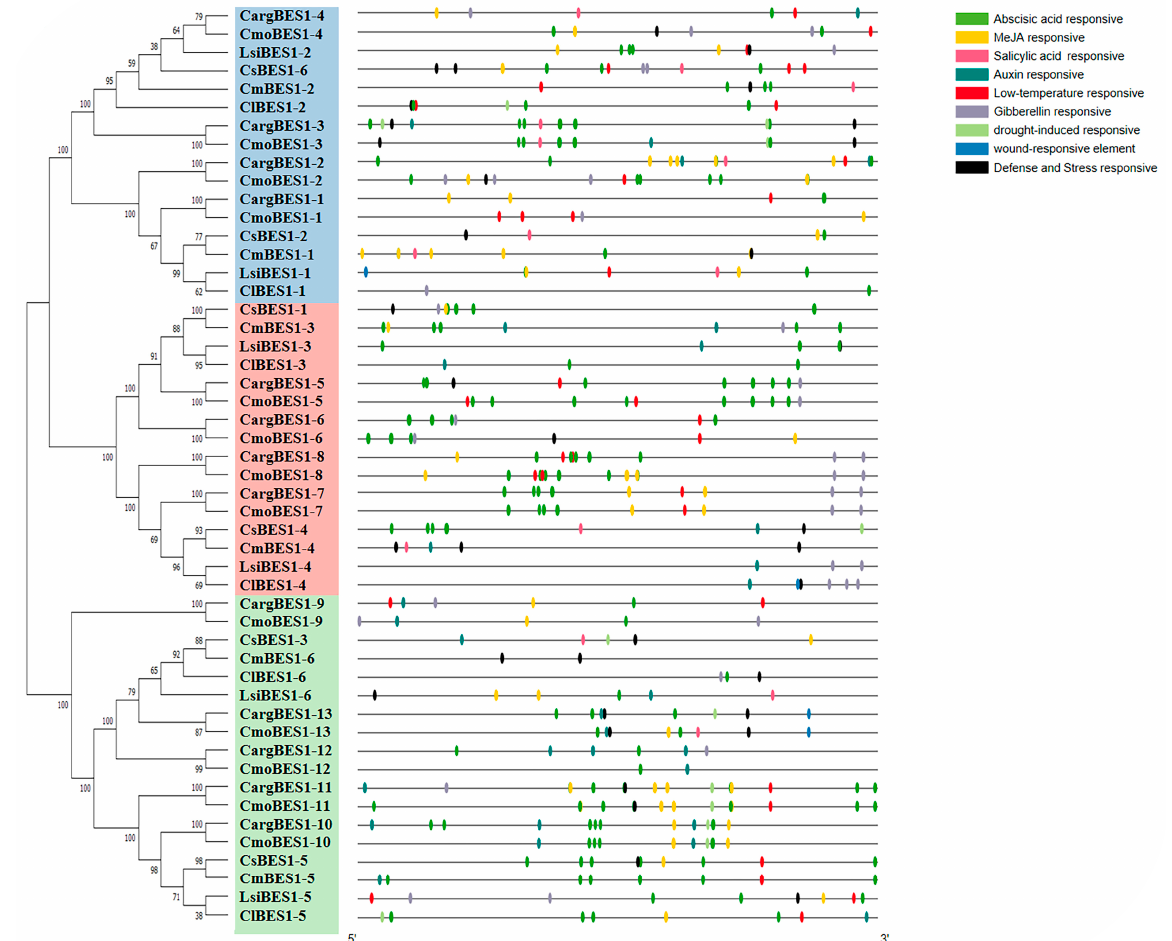
Figure 4. The distribution of stress-responsive cis -acting elements in the promoter regions of BES1 genes of silver-seed gourd, watermelon, cucumber, winter squash, bottle gourd, and melon. The cis -acting regulators of the 2 Kbp sequence upstream of BES1s were predicted through the PlantCARE database website. The green, yellow, pink, dark green, red, gray, laurel green, blue, and black ovals represent abscisic acid response elements, MeJA response elements, salicylic acid response elements, auxin response elements, low-temperature response elements, gibberellin response elements, drought response elements, wound response elements, and defense and stress response elements, respectively.